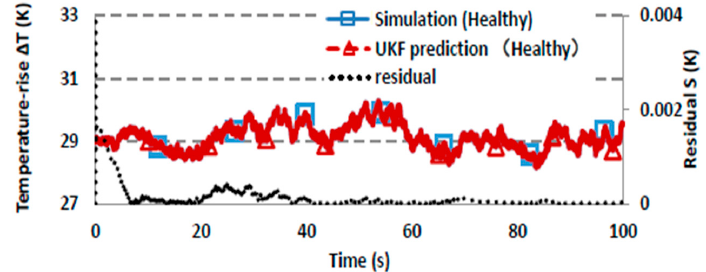
Figure 4. Comparison results of simulation and unscented Kalman filter (UKF) prediction for a WT in health.